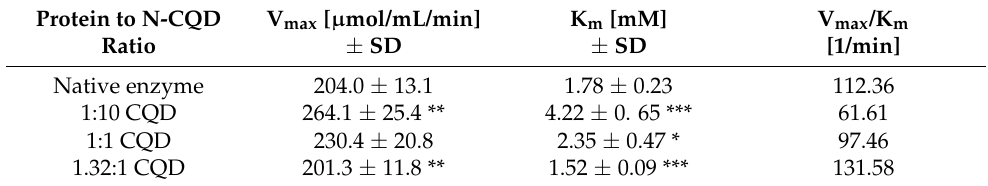
Table 2. Kinetic parameters of native and immobilized catalase. The statistical significance of the differences between native and immobilized enzyme is marked with asterisks (* for p ≤ 0.05, ** for p ≤ 0.01, *** for p ≤ 0.001).